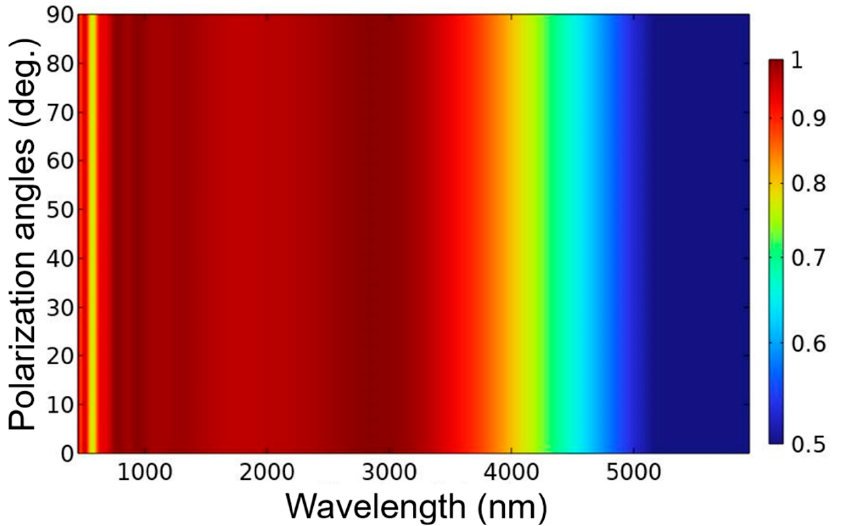
Figure 9. Evolution absorptivity of TE-polarized light with normally incident light in different polarization angle.